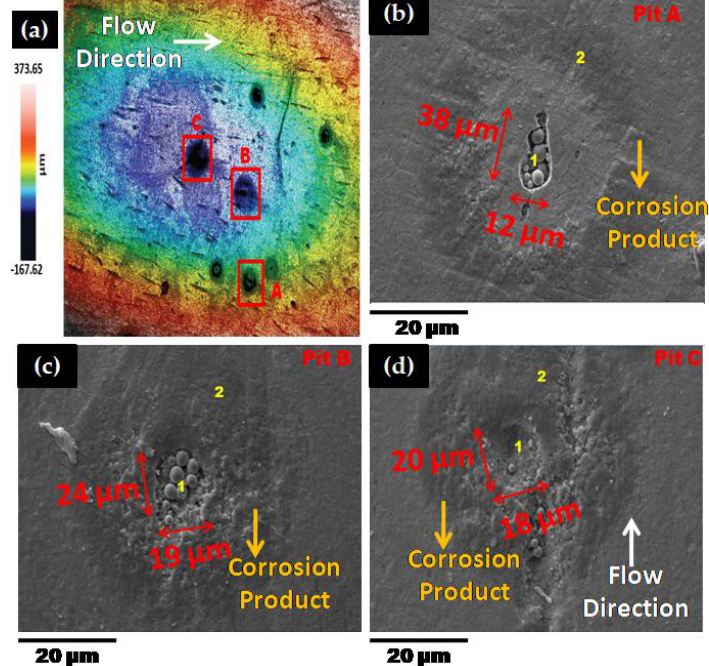
Figure 9. Micrographs of 90° elbow exit section for 2 wt.% sand fines concentration ( a ) confocal and ( b – d ) SEM inside pit (1) and outside pit (2). ( b – d ) SEM inside pit (1) and outside pit